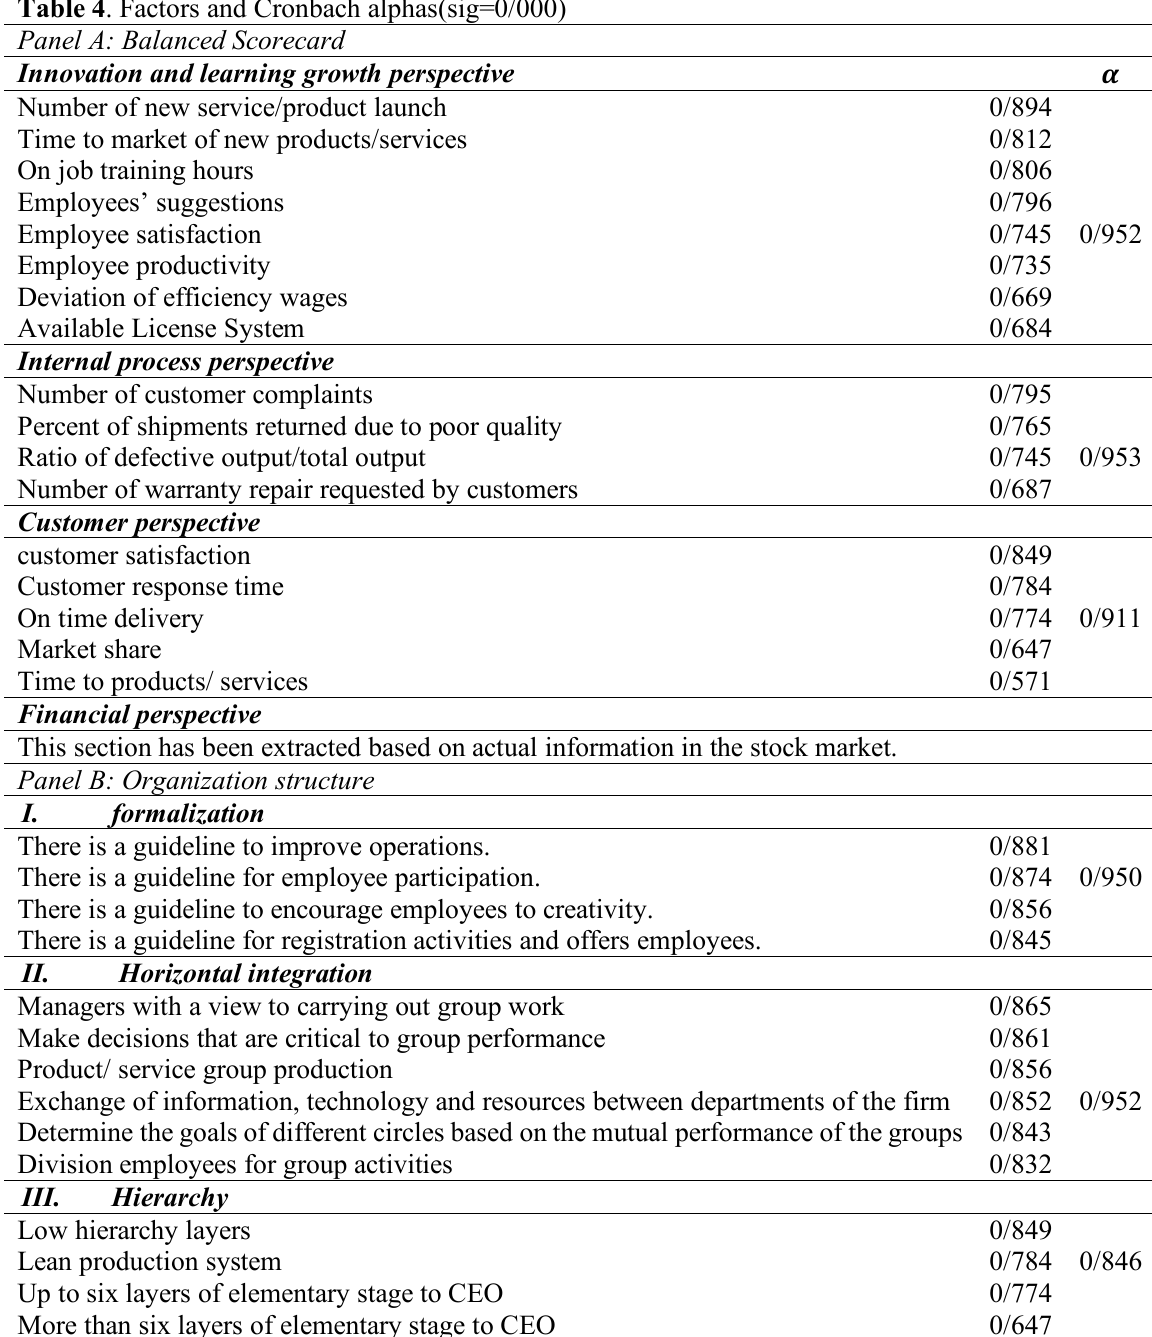
Table 4 . Factors and Cronbach alphas(sig=0/000) Panel A: Balanced